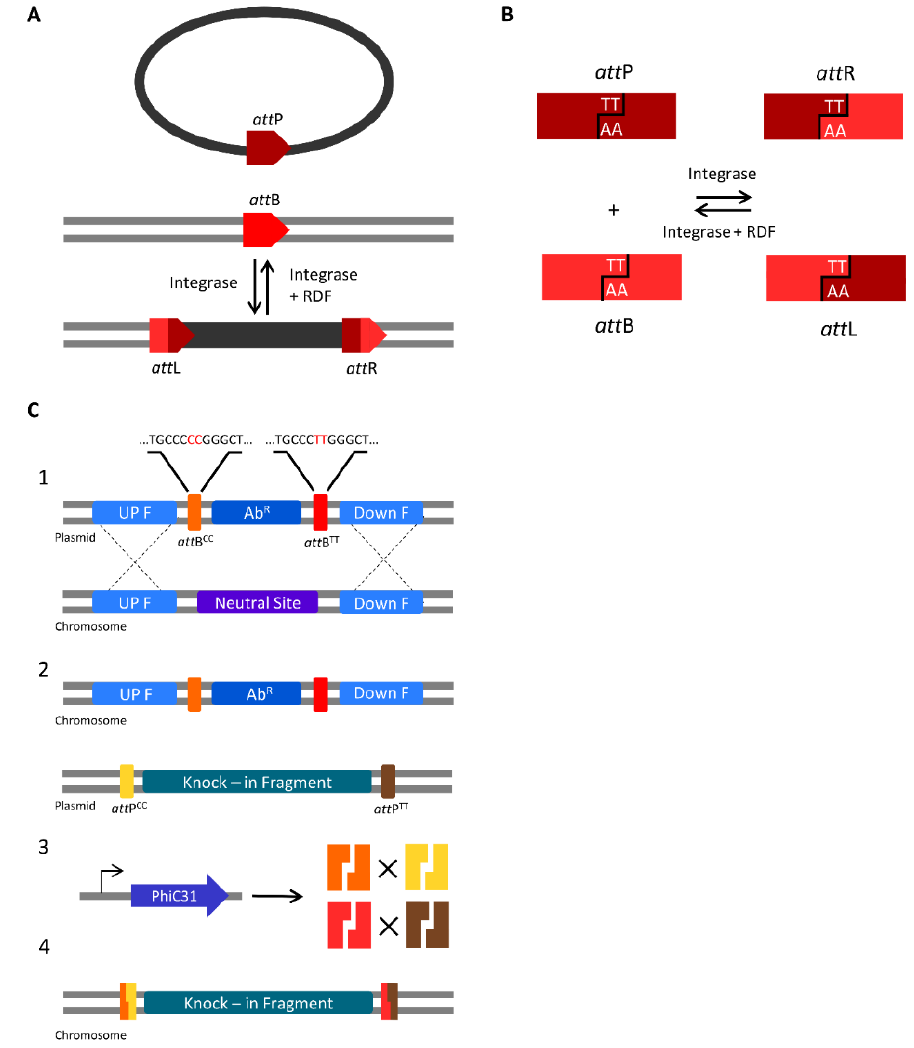
Figure 2. Mechanism of action of serine integrases and knock-in strategies. ( A ) DNA rearrangement with serine integrases: att B and att P sites recombine to make att L and att R sites. In the presence of the cognate recombination directionality factor (RDF), the reaction is reversed [124]. ( B ) The serine integrases bind to the att P and att B sites, generate a staggered 2 bp cut to produce two halves at each site, and then rotate to swap the two halves from each site. If the halves are complementary, relegation occurs to generate att L and att R sites. ( C ) A serine integrase-mediated knock-in strategy for cyanobacteria. Integration of a landing pad (the landing pad shown carries orthogonal att B CC and att B TT sites) occurs by homologous recombination (HR) at a neutral site in the cyanobacterial chromosome (C1). A self-replicating vector carrying the donor DNA fragment flanked by att P CC and att P TT sites and a PhiC31 integrase expression cassette is introduced into the cyanobacterial strain (C2). Expression of PhiC31 integrase results in the recombination of the orthogonal att B and att P pairs (C3), replacing the “landing pad” with the donor DNA to generate an unmarked knock-in mutant (C4).